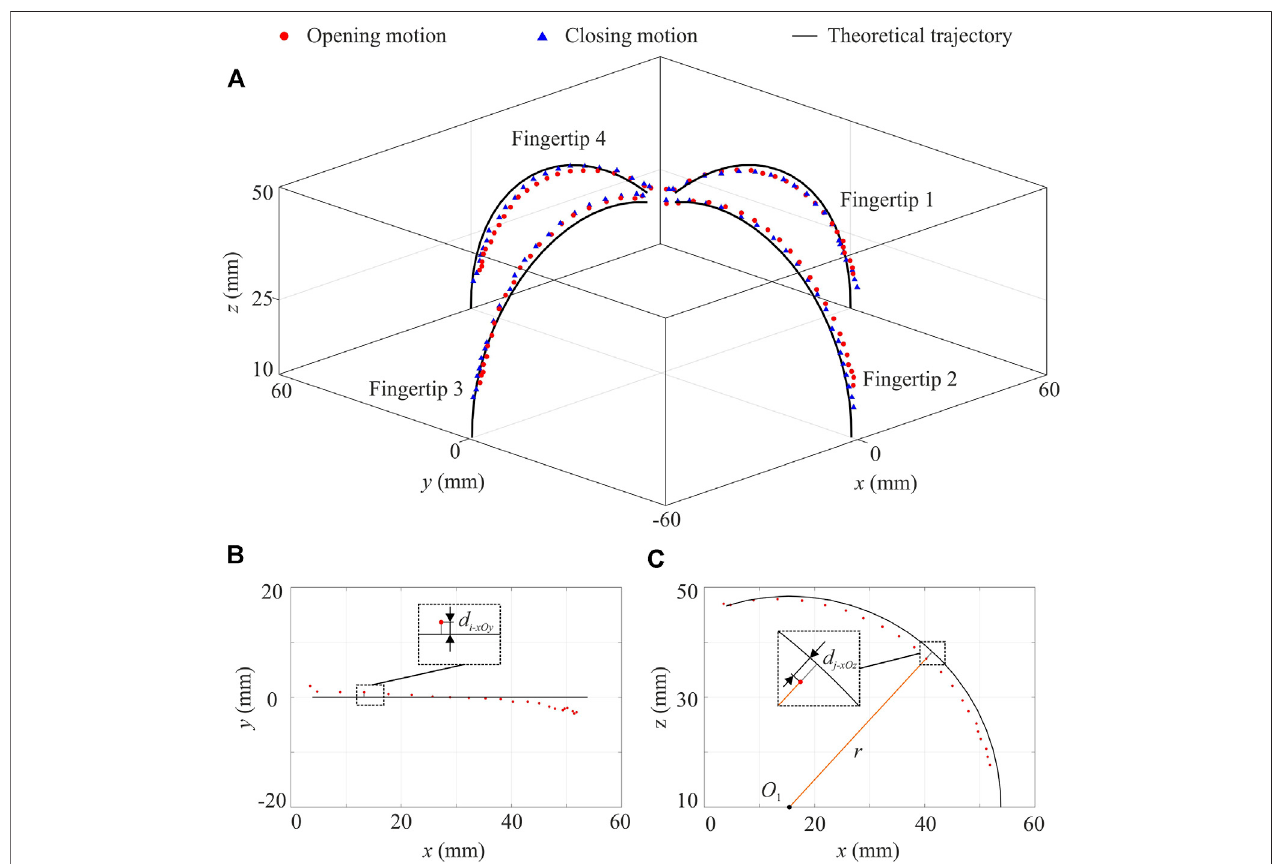
FIGURE7| Motiontrajectoriesandpositionerrorsofthegripper. (A) Experimentalresultsof3D fi ngertippositionsintheopeningandclosingmotionstogetherwith the theoretical trajectories. Calculation of position error in (B) the xOy plane and (C) the xOz plane by taking a random position in the opening motion of fi ngertip 1 as an example. Theoretically, in the xOy plane, all positions ’ x -coordinates (for fi ngertips 2 and 4) or y -coordinates (for fi ngertips 1 and 3) are zero. Each position error is the absolute value of the position ’ s x -coordinate or y -coordinate. The error of fi ngertip 1 ’ s i -th position in the opening motion is plotted as d i - xOy . In the xOz plane (for fi ngertips 1 and 3) or yOz plane (for fi ngertips 2 and 4), the theoretical trajectory of each fi ngertip is part of a circle. The position error here is thus quanti fi ed as the displacement from the circle. The position error of the j -th position of fi ngertip 1 is marked as d j - xOz .